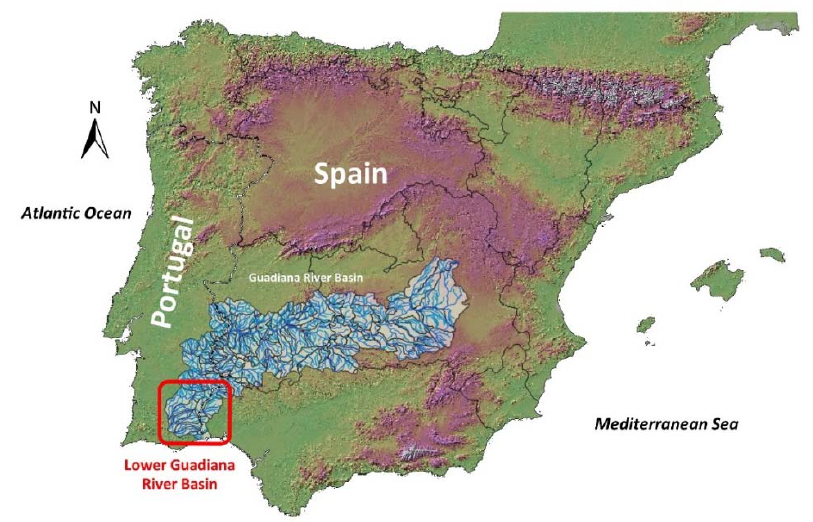
Figure 1. The Guadiana River Basin in the Iberian Peninsula: Localization of the study area (the hydrographic region of the International Lower Guadiana River ; http://ide.unex.es/conocimiento/ and [17]).